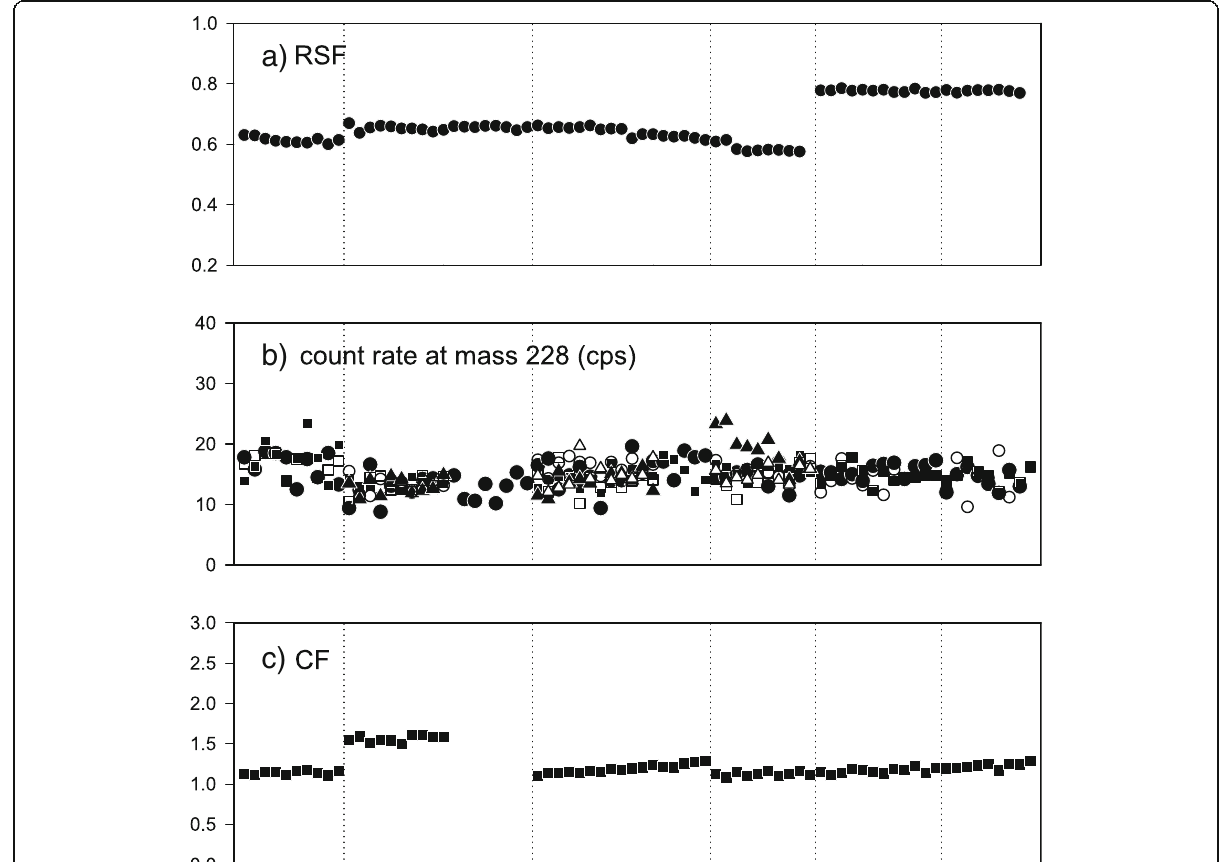
Fig. 4 Variation of a the relative sensitivity factor (RSF) measured for the 91500 zircon (= 2.85 over 238 U/ 232 Th measured ), b the count rate at mass 228, and c the correction factor (CF) measured for the Ple š ovice zircon [= ( 238 U/ 232 Th) corrected /( 230 Th/ 232 Th) measured ] in the LA-MCICPMS analysis. Symbols are the same as in Fig.